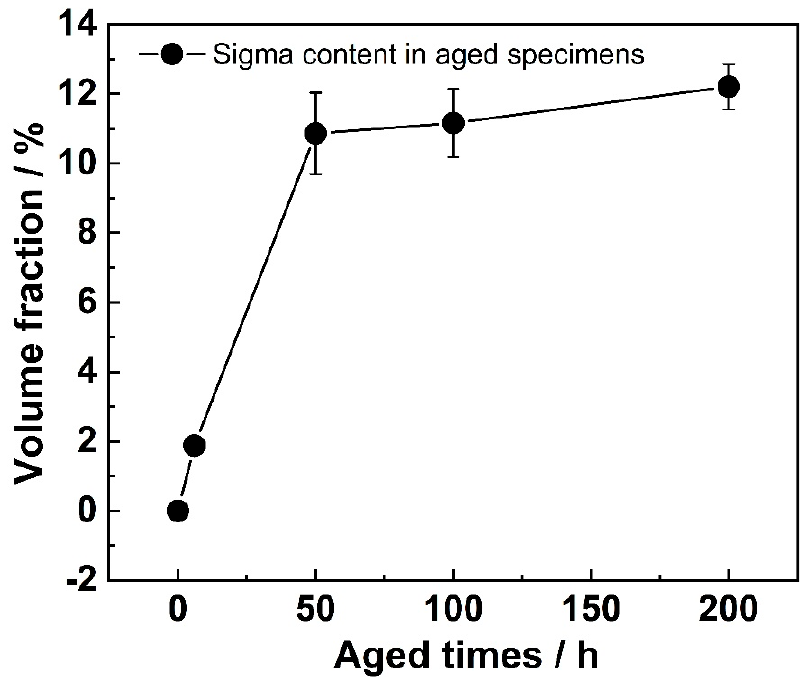
Figure 8. Variation in sigma content in Z3CN20.09M CASS specimens aged at 750 °C with aging times.